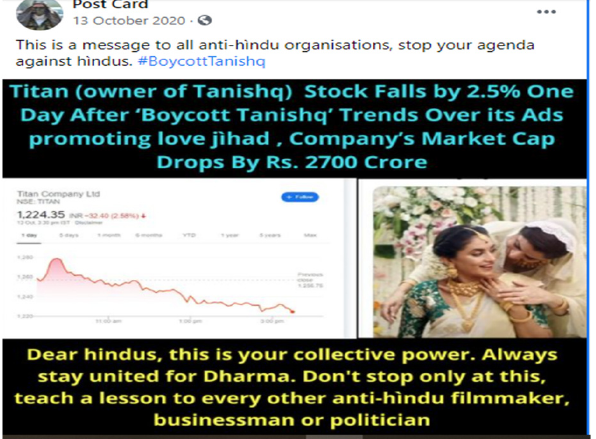
Figure 14. Facebook posts celebrating the success of #BoycottTanishq campaign and the resultant losses that forced the jewelry brand to take down the TV ad.